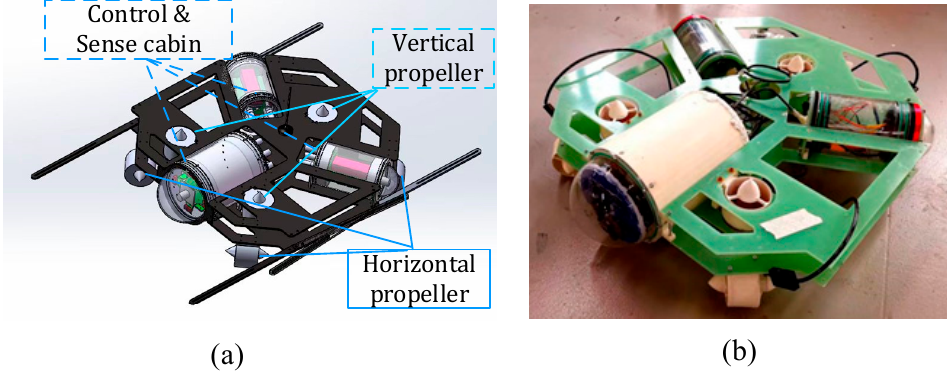
Figure 2. An omnidirectional mobile AUV: ( a ) structural design; ( b ) real products.